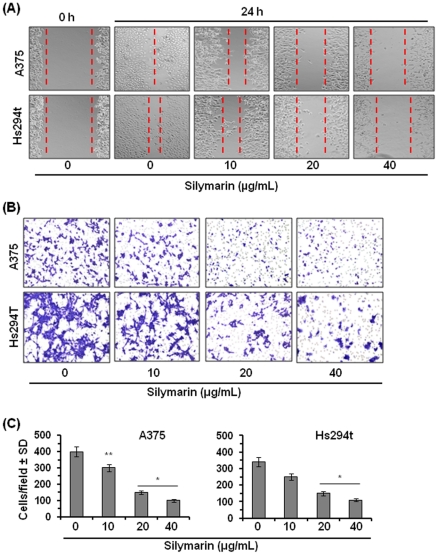
Silymarin inhibits melanoma cell migration and/or invasion in a concentration-dependent manner.(A) Wound healing assay was performed to assess the effect of silymarin on the migration of A375 and Hs294t human melanoma cells. Incubation of A375 or Hs294t cells with silymarin for 24 h inhibits migration of cells in a concentration-dependent manner compared to non-silymarin-treated control cells. Broken red line indicates the gap without the presence of cells. Assay was repeated three times and representative pictures are shown. (B) Treatment of human melanoma cells with silymarin inhibits migration or invasion ability of cells. Treatment of A375 or Hs294t human melanoma cells with silymarin for 24 h inhibits invasion of cells in a concentration dependent manner. (C) The migratory cells were counted on membrane in at least four to five randomly selected microscopic fields and the results are summarized and expressed as the mean number of migratory cells ± SD per microscopic field. Significant difference versus non-silymarin treated control group, *
P<0.001, **
P<0.01.